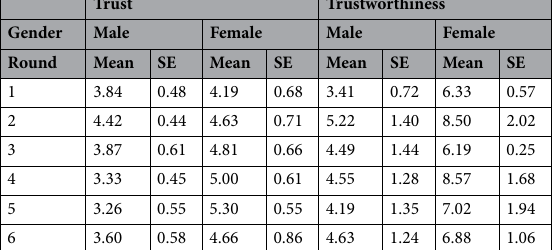
Table 1. Trust and trustworthiness by rounds and gender. SE standard